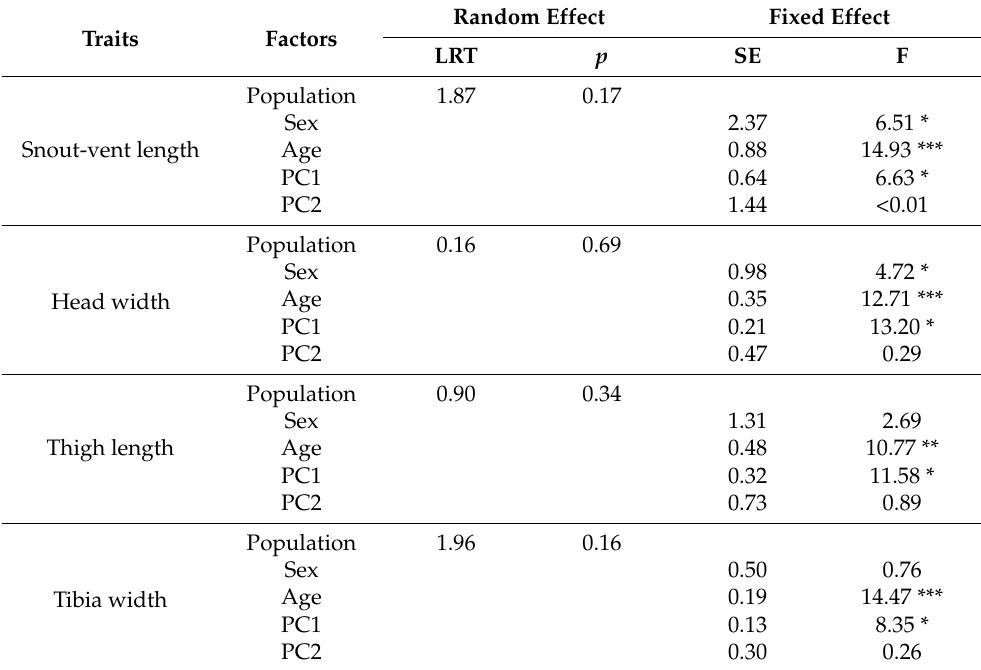
Table 1. Results of linear mixed models (LMMs), assessing the effects of environmental predictors along PCs (PC1 and PC2) on morphological traits (i.e., snout-vent length, head width, thigh length, and tibia width), age and sex were considered as covariates. Random Traits Factors